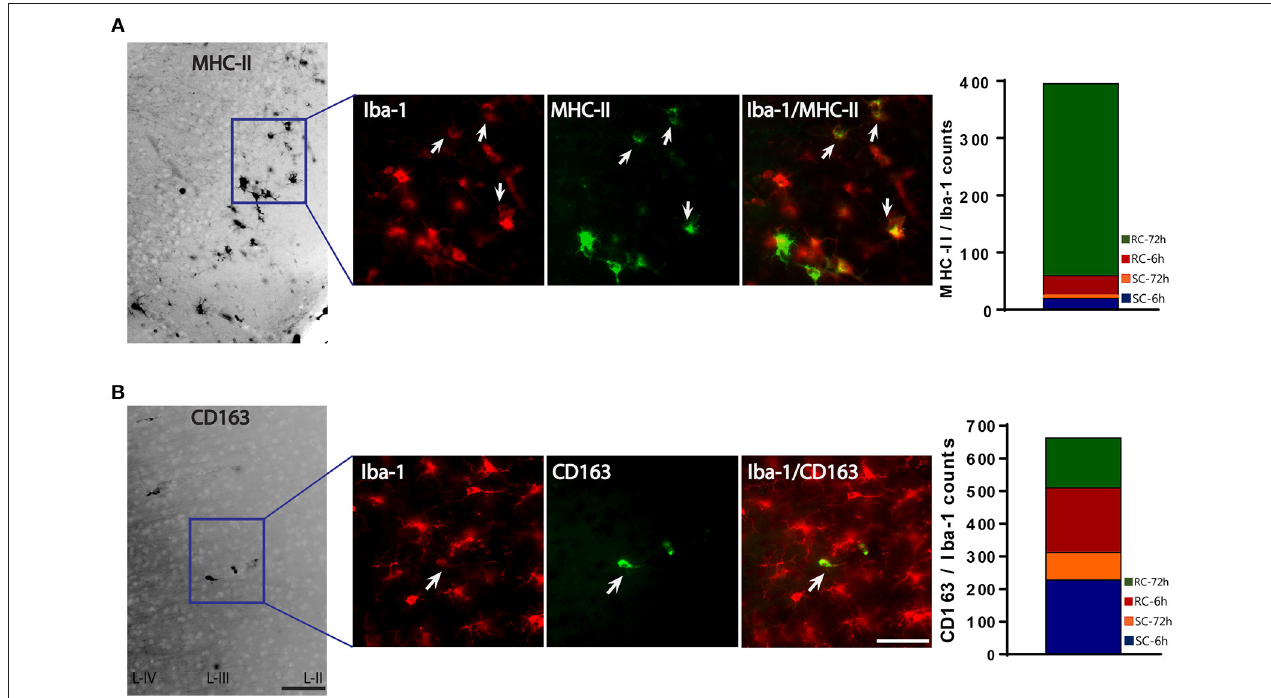
FIGURE 8 | M-1 and M-2 marker expression by activated microglia in the ipsilateral cortex. (A) MHC-II (M-1 marker) stained microglia co-labeled with Iba-1 were found mainly in the entorhinal cortex. Co-localized cells were counted from entire cortex. (B) CD163 (M-2 marker) stained microglia co-labeled with Iba-1. Co-localized cells were counted from entire cortex (bar graphs). Arrows indicate co-localized cells. Scale bar = 50 µ